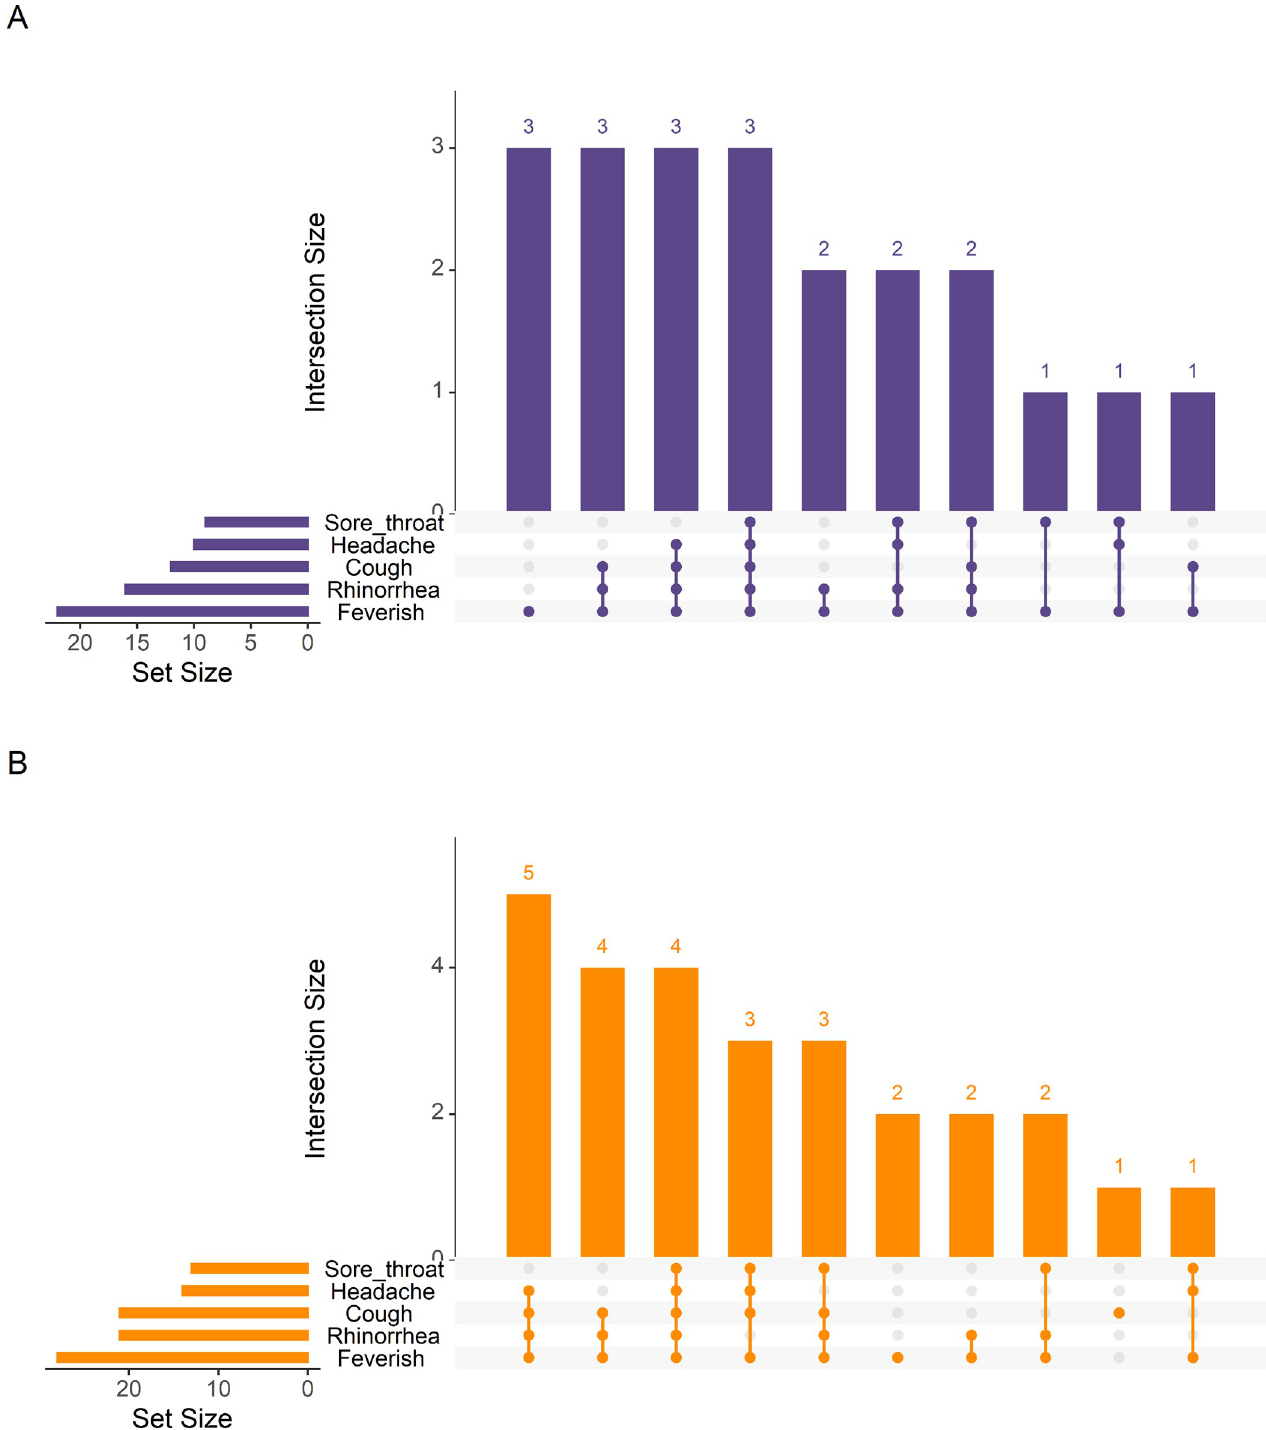
Fig 4. Comparison of common symptom groupings between symptomatic SARS-CoV-2 Infections in 2020 and 2021 A: 2020. B. 2021.